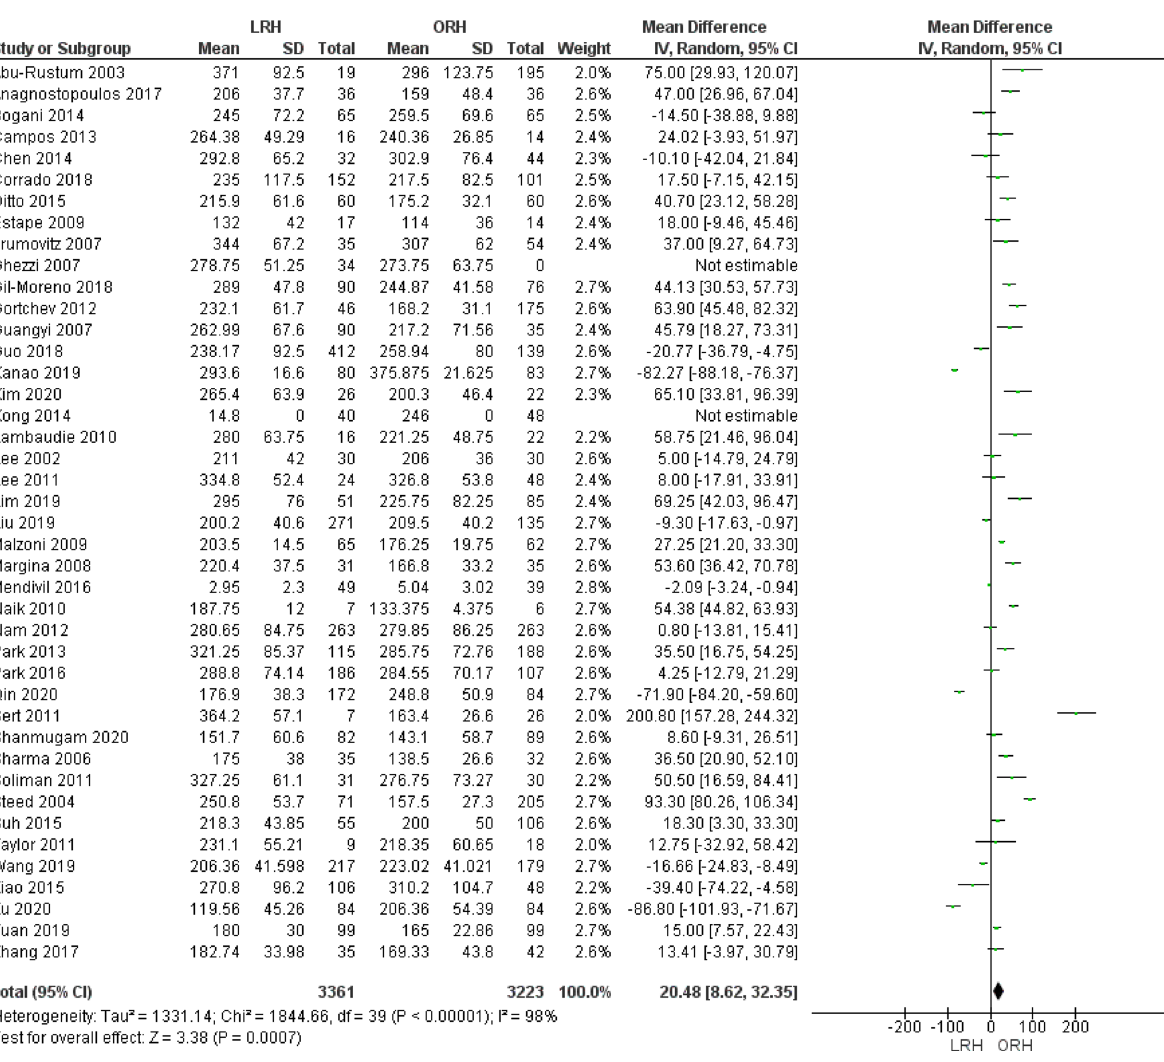
Figure 2. Forest plot of operative